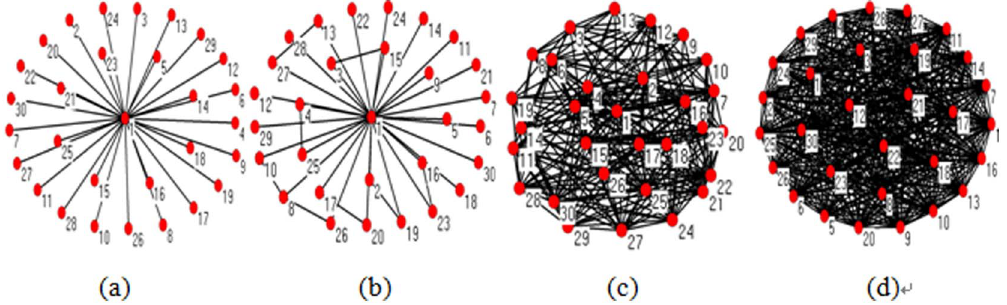
Figure 2. Several cases with number of edges gradually increasing and the fixed nodes. In Figure 2 (a), N =30, M =29, and Bre 1 =0.0345. In Figure 2 (b), N =30, M =37, and Bre 1 =0.0577. In Figure 2 (c), N =30, M =275, and Bre 1 =0.1319. In Figure 2 (d), N =30, M =435, and Bre 1 =0.1332. The value of Bre 1 reflects the connectivity of the node 1.